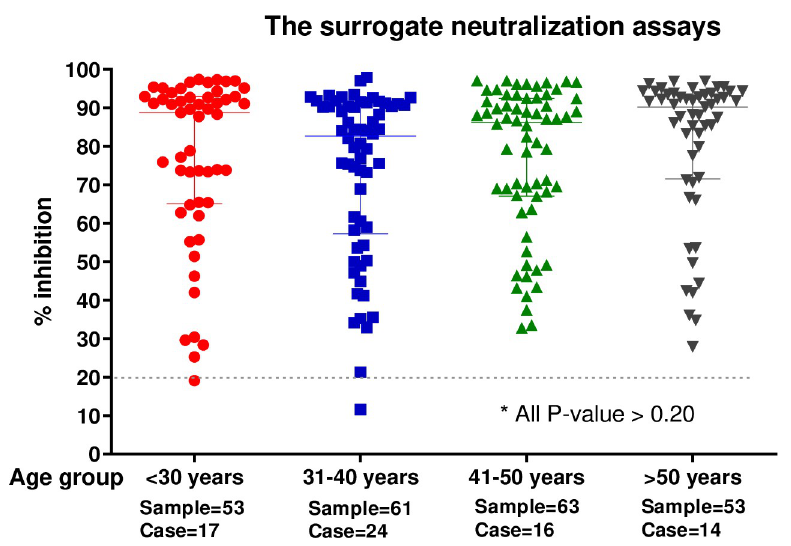
Fig 4. Comparison of sVNT results (%inhibition) between COVID-19 patients in different age groups (lateral axis). Every dot represents one tested specimen and the vertical axis represents the %inhibition of SARS-CoV-2 NAbs tested by sVNT. The dashed line represents the cutoff at 20% inhibition. The horizontal lines indicate the median interquartile range (IQR). The p values were calculated from two-tailed test.